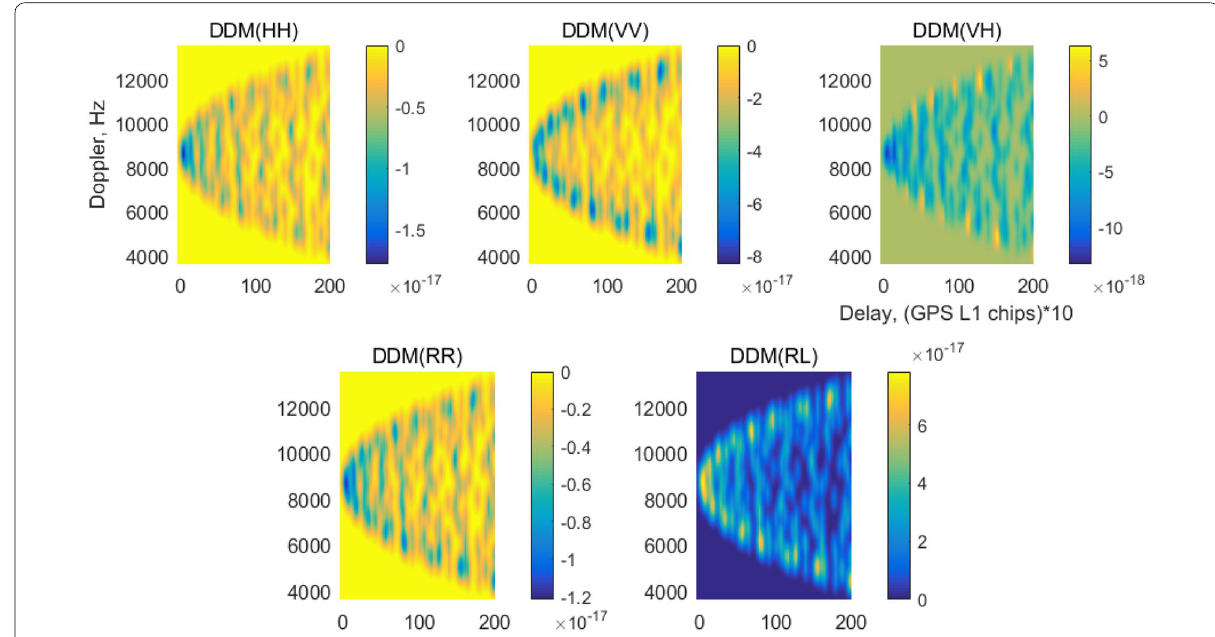
Fig. 6 Bare soil surface roughness effects on DDMs at linear and circular